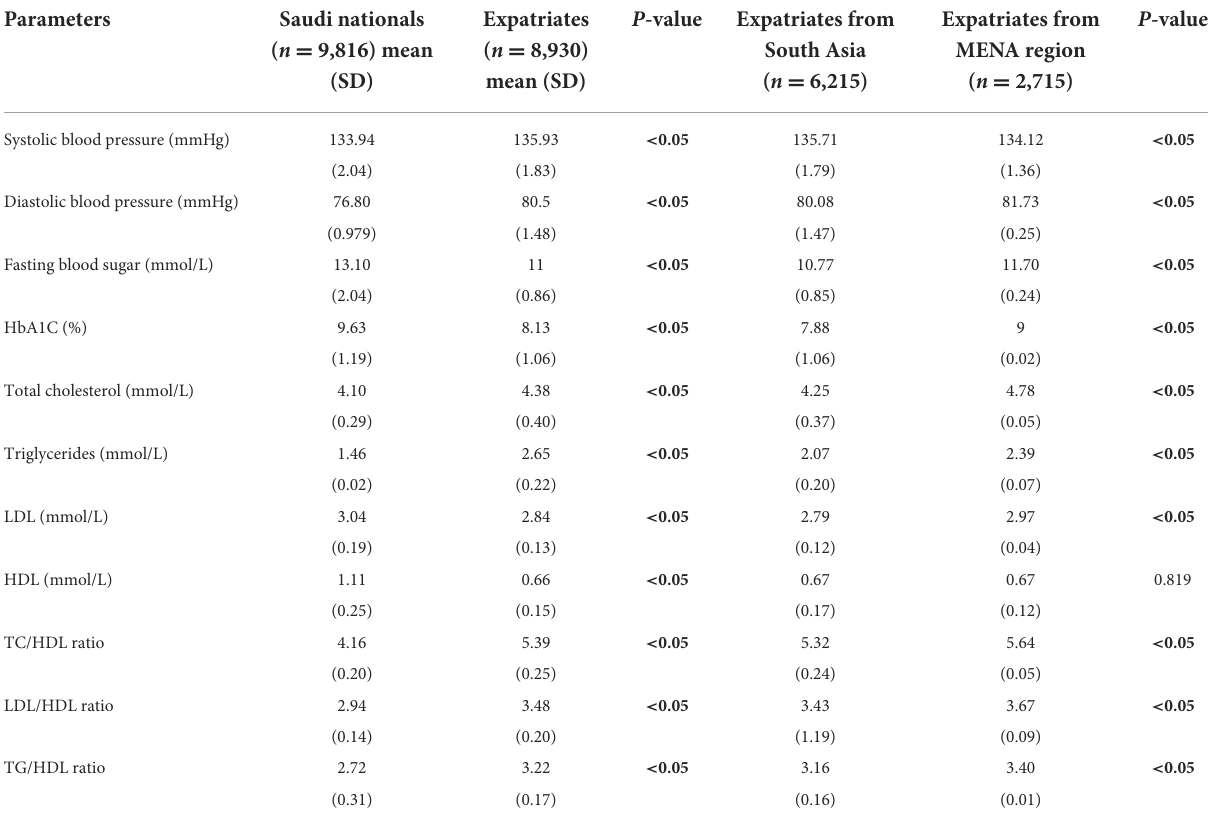
TABLE 5 Assessment of measurable parameters between Saudi Nationals and Expatriates.